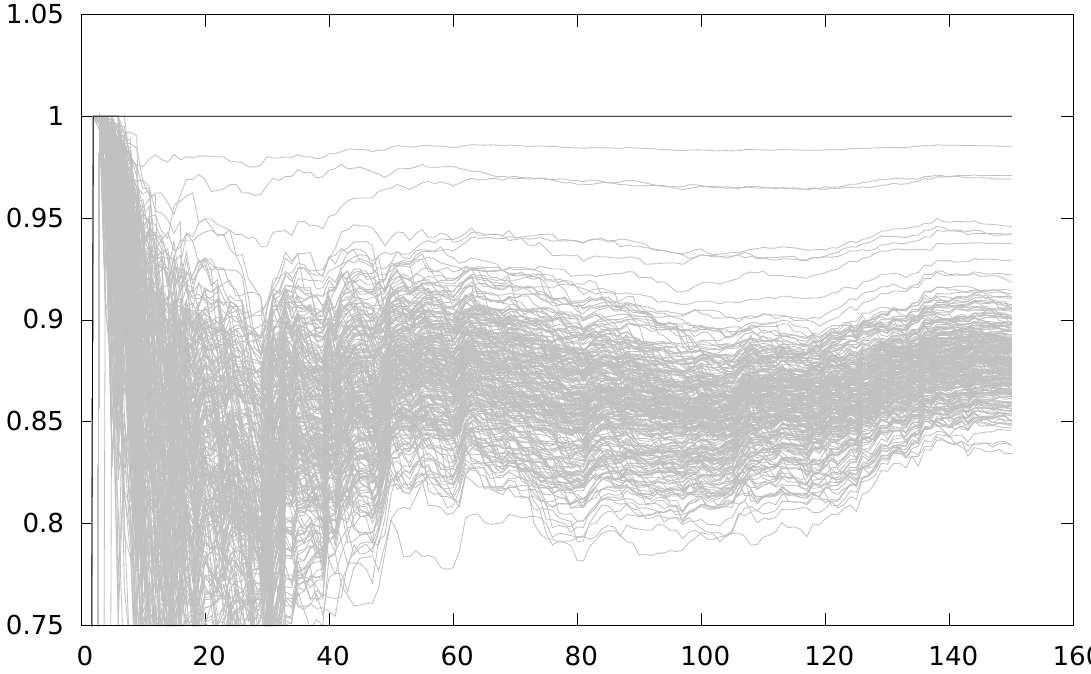
Figure 8. Maximum correlation for different key guesses vs . number of power traces with a partial loop unrolling of 2